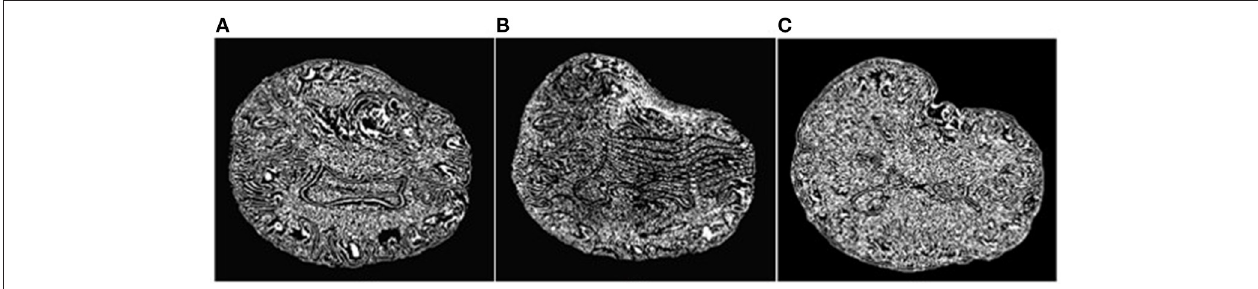
FIGURE 7 | Extracted Canny points in a single slice for quantitative evaluation of registration accuracy using the HD metric. (A) : Points extracted from the preoperative MRI; (B) : Points of (A) after transformation to the intraoperative space; (C) : Points extracted from the intraoperative MRI. The HD metric is computed between point sets (B) and (C) . Note that the Canny points are generally different from feature points used for